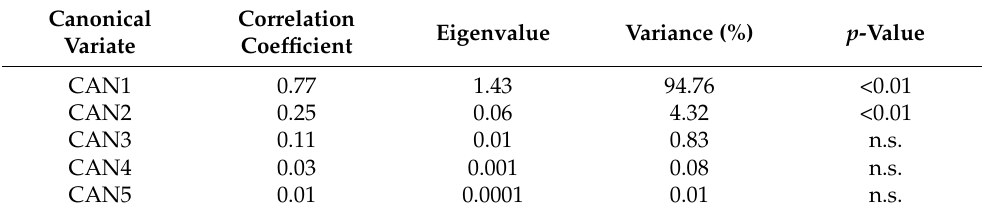
Table 4. Canonical variates, correlation coefficients and explained variance.